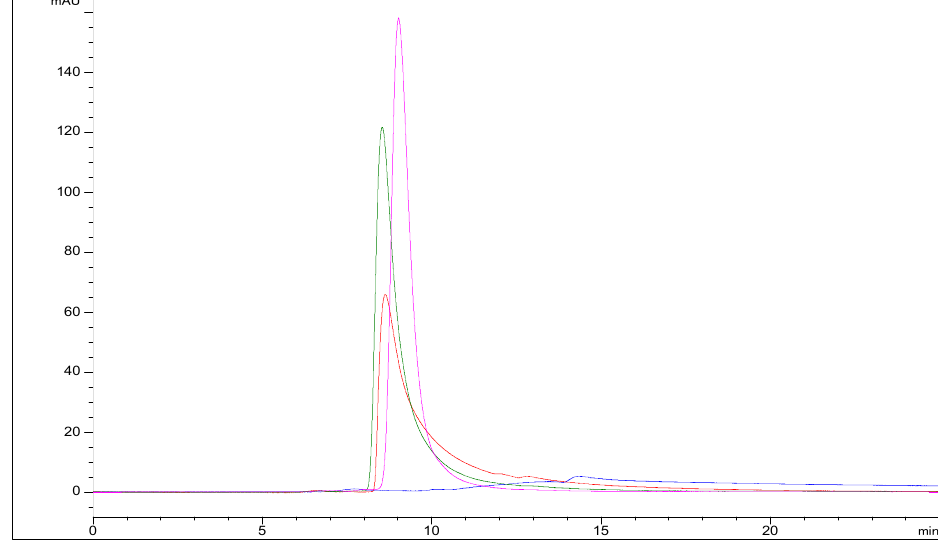
Figure A7. The effect of NaCl concentration in the mobile phase on LF peak shape (SEC column BioSep™-SEC-S 2000): −− 0.0 M NaCl, −− 0.15 M NaCl, −− 0.3 M NaCl, and −− 0.5 M NaCl. Separation was performed on a BioSep™-SEC-S 2000 column at 25 °C using 0.05 M sodium phosphate buffer containing NaCl (pH 7.0) as a mobile phase at a flow rate of 0.8 mL/min).